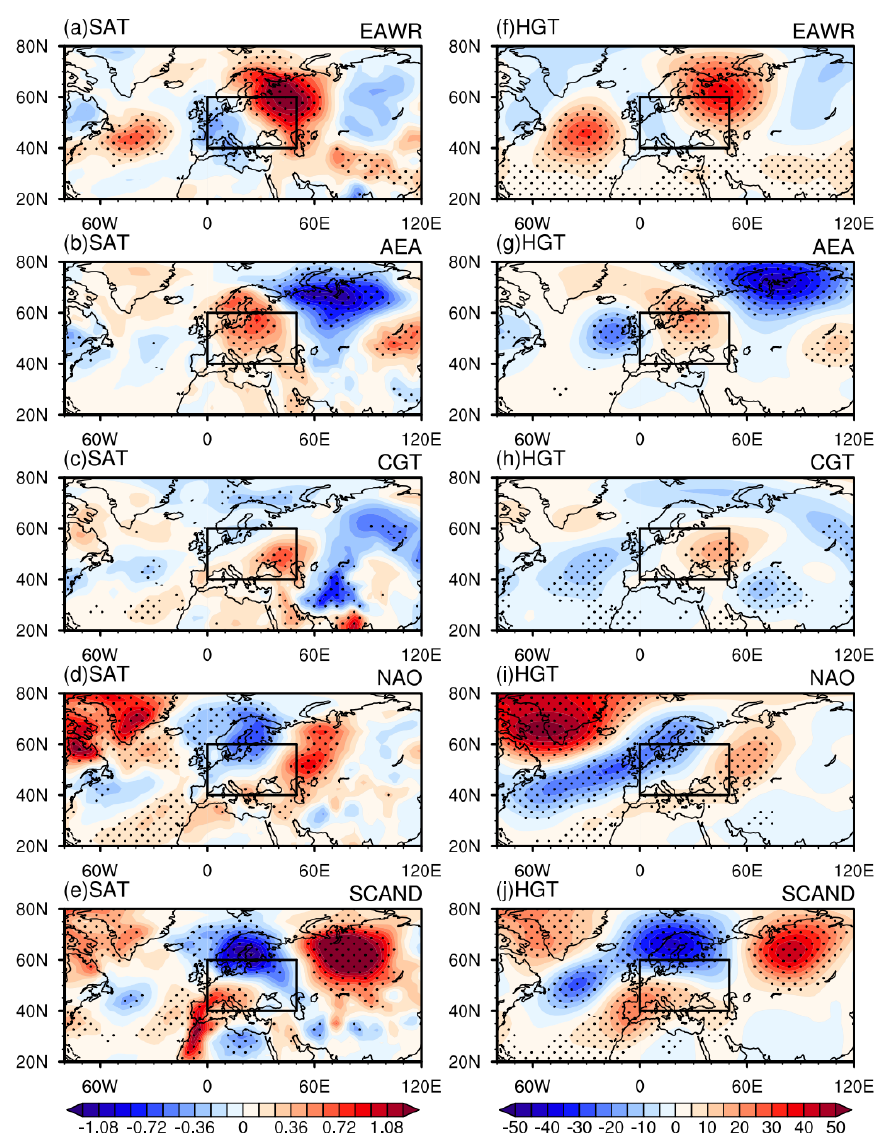
Figure 5. Anomalies of ( a – e ) SAT (unit: ◦ C) and ( f – j ) 500-hPa geopotential height (unit: gpm) regressed upon the EAWR, AEA, CGT, NAO and SCAND teleconnection indices. Please see Section 2 in the text for the detailed definitions of the above teleconnection indices. Stippling regions in ( a – e ) and ( f – j ) represent SAT and 500-hPa geopotential height anomalies exceeding one standard deviation, respectively.